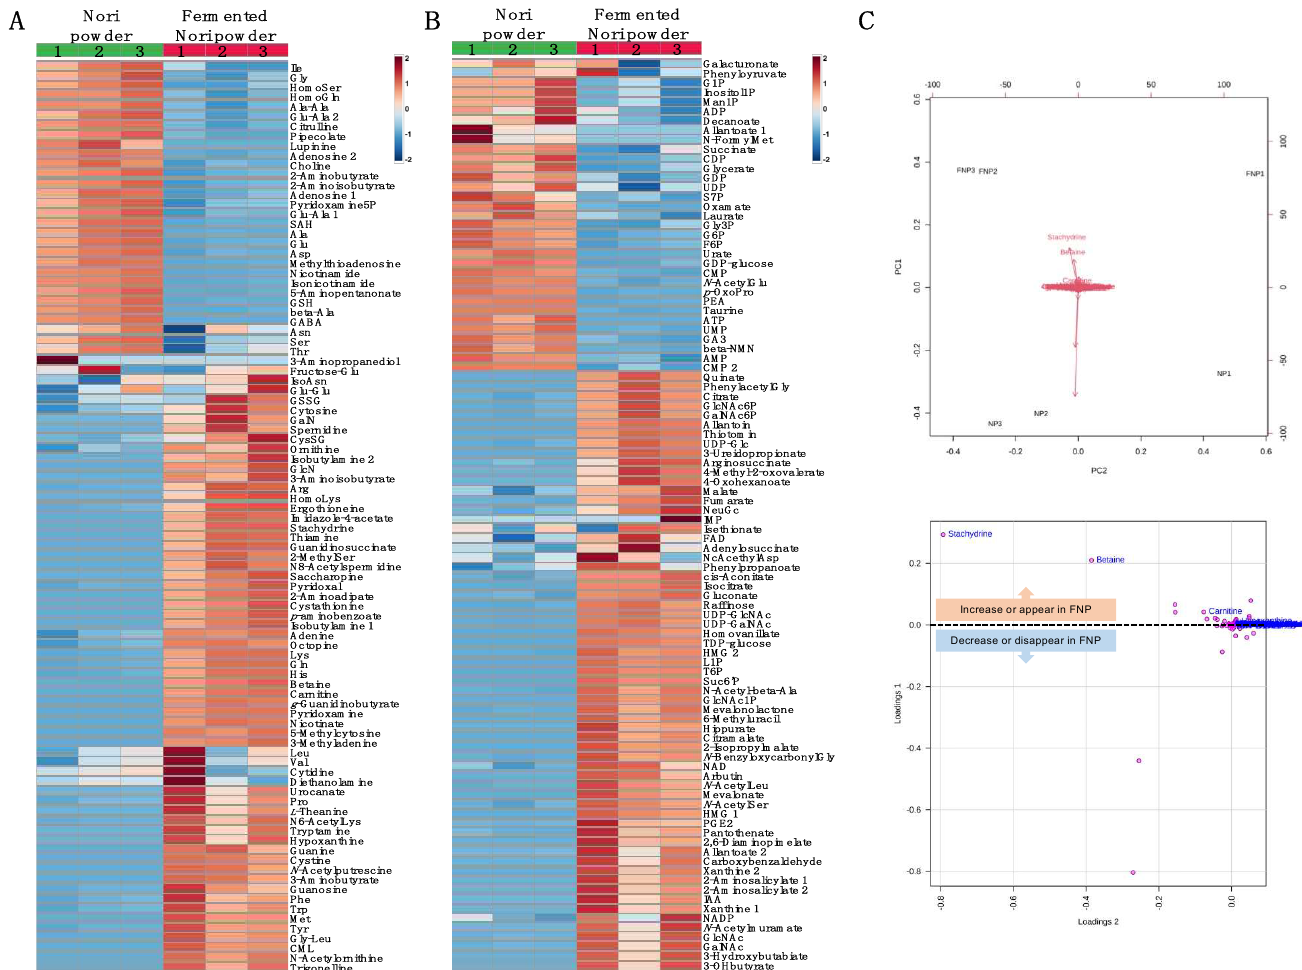
Figure 8. Heat map analysis and principal component analysis of the 189 metabolites significantly modified by Koji fermentation. ( A : Cationic mode, B : Anionic mode) The normalized values were transformed into a z-score and shown as a color scale. The high and low metabolite levels were represented as reddish and blueish scales, respectively. ( C ) Principal components analysis: biplot (upper figure) and loading plot (lower figure) from metabolites of powders before and after Koji fermentation. Labeled variables were detected only in FNP. NP: Nori powder, FNP: fermented Nori powder.